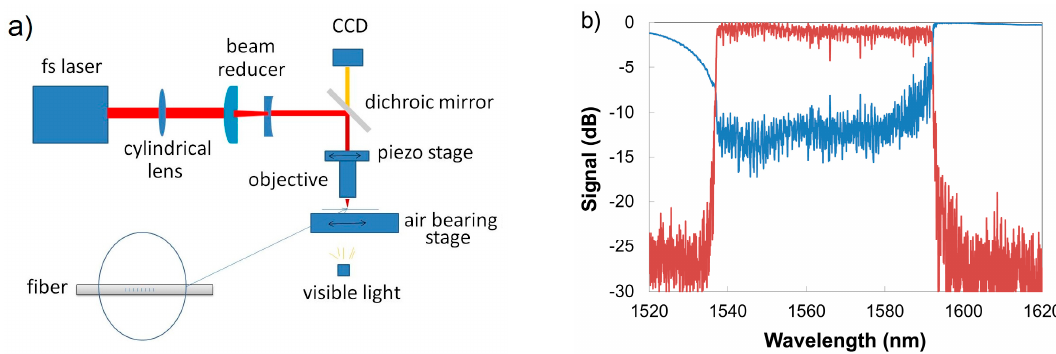
Figure 17. ( a ) schematic representation of the plane-by-plane exposure set up; ( b ) Transmission (blue) and reflection spectra (red) of the 26 cm long chirped fiber grating in SMF-28 fiber made using the plane-by-plane